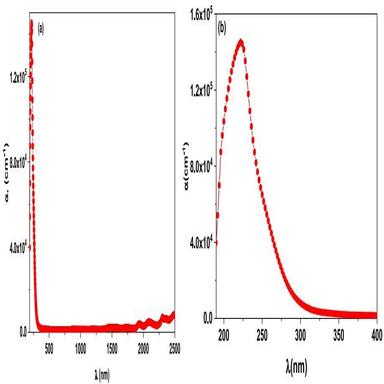
(a) Spectral distribution of absorption coefficient,α in all studied ranges, (b) Spectral distribution of absorption coefficient,α in the first range of PVA structure.